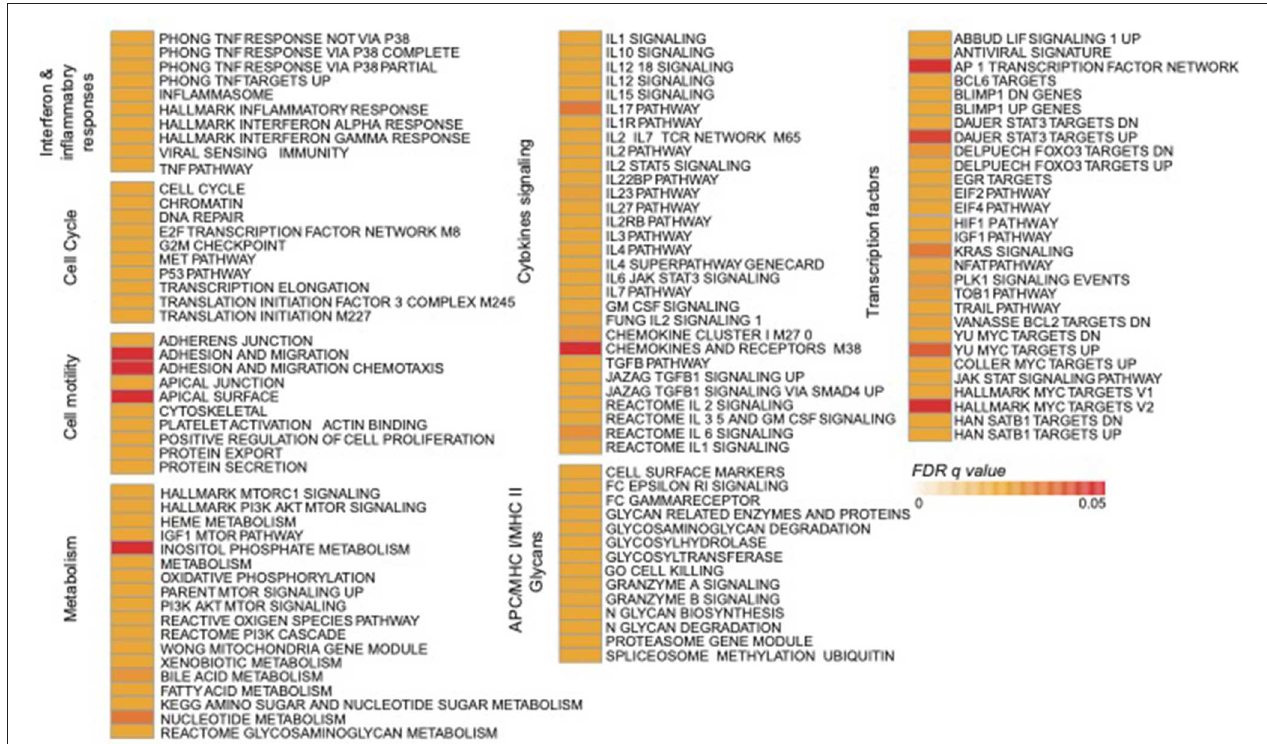
FIGURE 3 | NK RMtsig revealed expression of a broad range of innate and adaptive immune pathways. Diagram showing all the significant pathways (FDR q value of the overlapping test < 0.05) enriched within the NK RMtsig. Pathways were grouped into modules of similar or close molecular function. The color gradient represents the gene overlapping FDR q value, ranging from light orange (FDR = 0) to dark red (FDR =